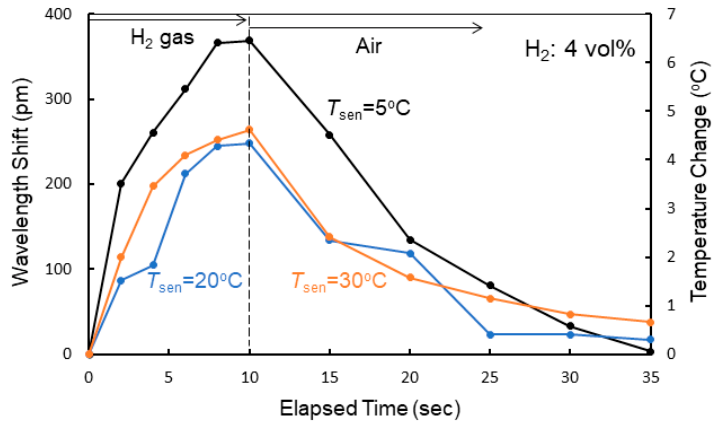
Figure 10. Wavelength shift as a function of elapsed time upon exposure to 4.0 vol% hydrogen gas at different temperatures.